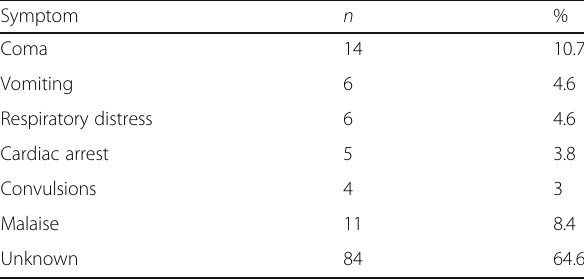
Table 2 Symptoms of the intoxication